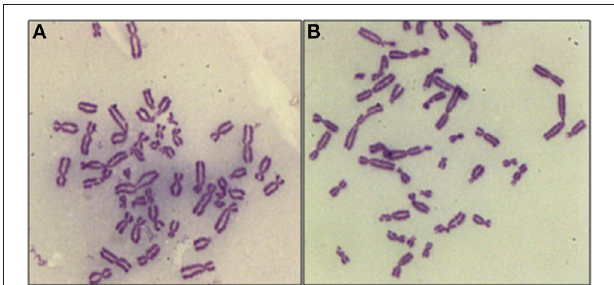
FIGURE 1 | Representative examples of CBs in RPE metaphases treated with VE-821 or left untreated. (A) CBs in a cell analyzed 1h after exposure to 1Gy. (B) As in A for a cell also exposed to VE-821 1h before IR. Note the increase in the yields of